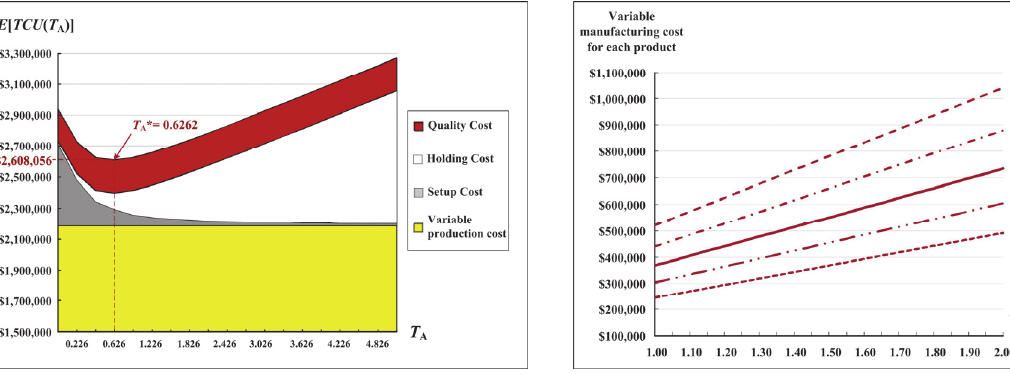
Fig. 5. Influences of variations in T A on E [ TCU ( T A )] and its different cost factors